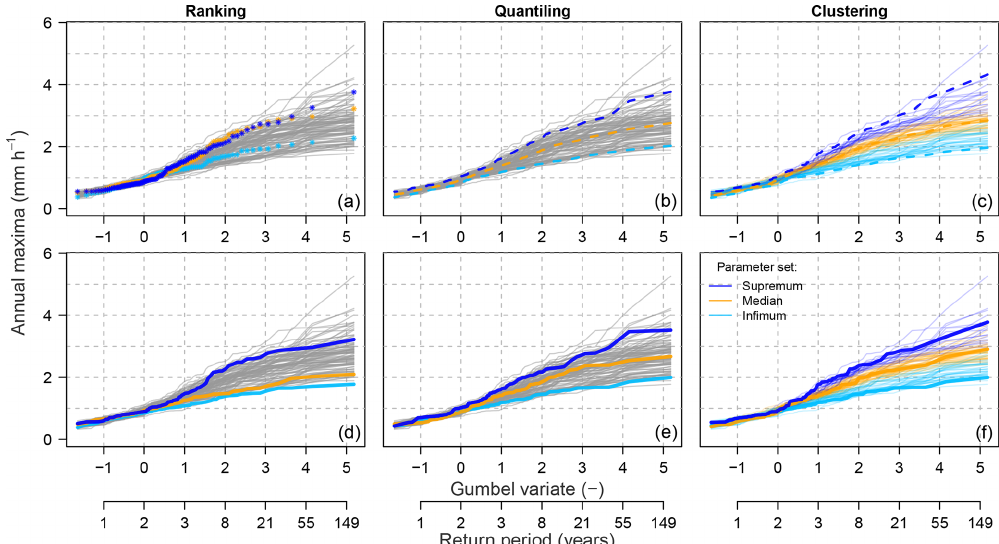
Figure 6. Example of the representative parameter sets’ selection with three methods in the Dünnern at Olten catchment (meteorological scenario m = 14). The top panel presents intermediate steps of selecting the representative sets and the bottom panel the finally constructed intervals, i.e. infimum, median and supremum. The dashed lines (top panel) indicate the computed representative intervals (i.e. steps a–c in ranking and clustering and a–b in quantiling), and the solid lines (bottom panel) indicate the hydrological-simulation members corresponding to the parameter sets selected as representative (step d in ranking and quantiling and e in clustering).